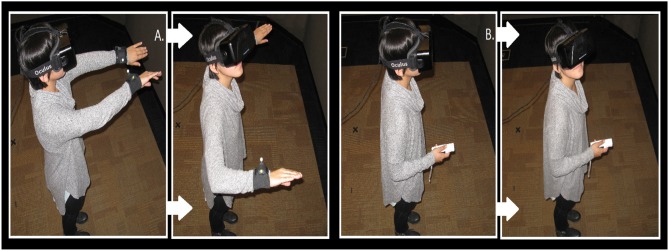
(A) In the Gestures condition, the participant is outfitted with Worldviz PPT-E infrared sensors attached to her wrists, to allow her to swim through the virtual ocean. The participant moves her arms in a breast-stroke-like motion to swim forward through the environment and turns her head to change direction. (B) In the Joystick condition, the participant uses a Wiimote controller to swim through the environment. She presses the arrow keys on the Wiimote controller to control the direction in which she swims and can turn her head to change directions.